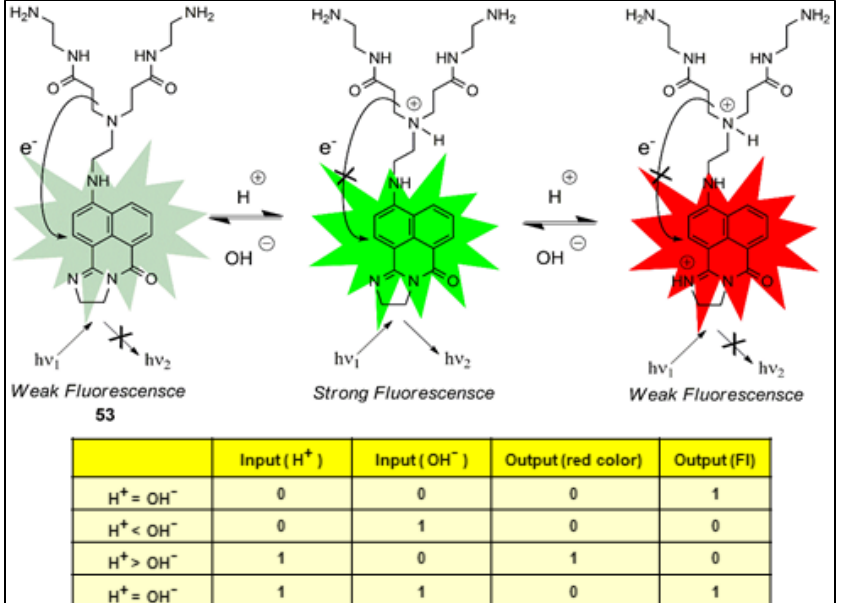
Figure 51. Photophysical behavior of probe 53 as a function of pH and truth table for operation of 53 -based digital comparator [156].